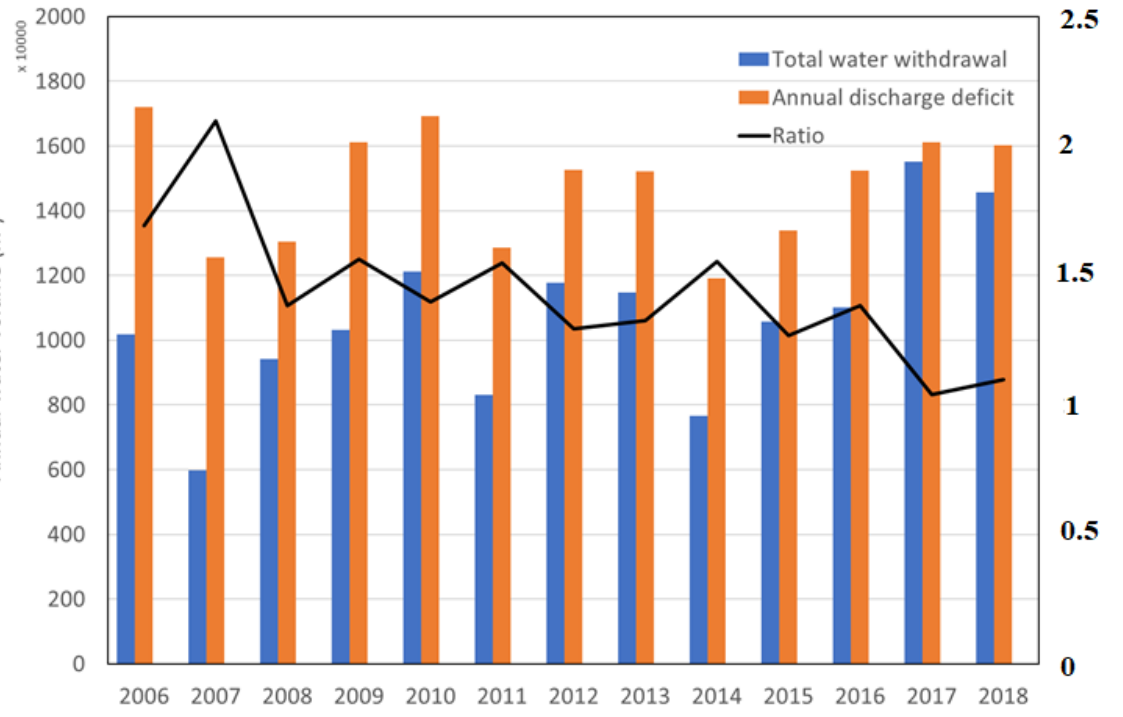
Figure 9. Comparison between total water annual volume available at the Touvre karst spring outlet and the total water withdrawal over the four sub-catchments. The ratio between the two volumes is also shown in order to highlight a strong variability between these two water availability indexes based on our nonlinear